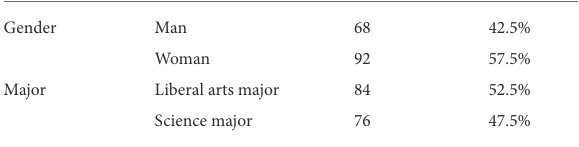
TABLE 1 Survey respondents’